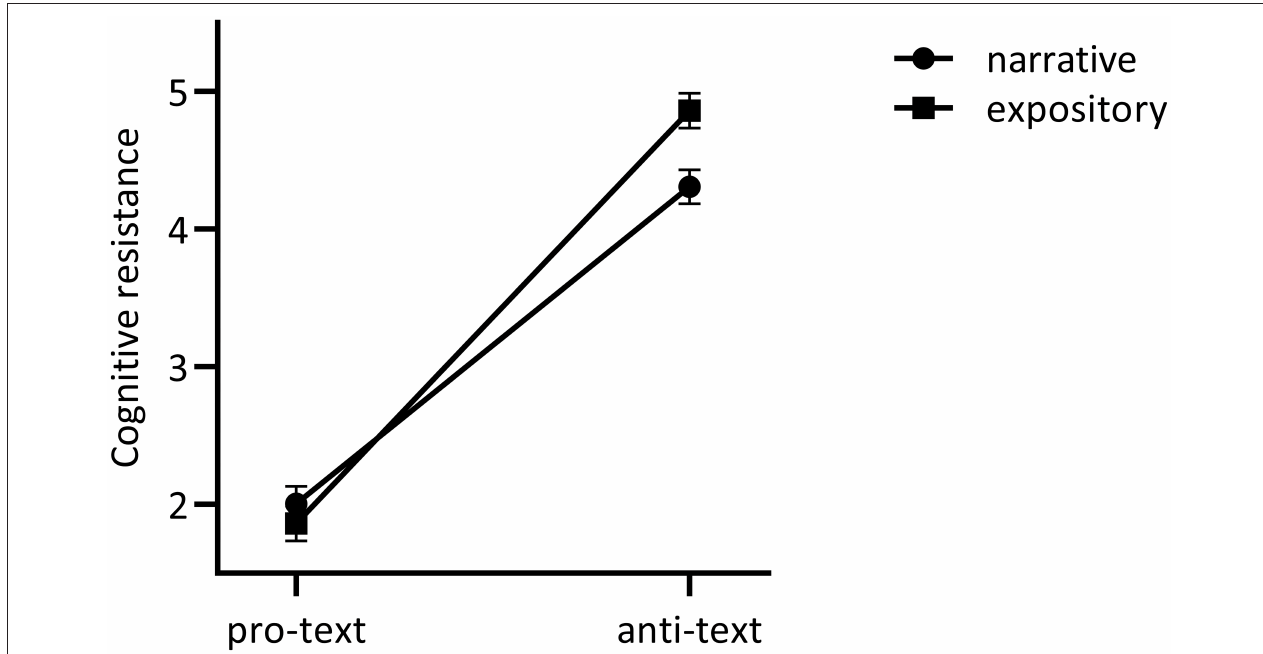
FIGURE 2 | Exploratory format*content interaction on attitude certainty. Bars reflect standard errors to the mean.